Question: What kind of plot is shown here?
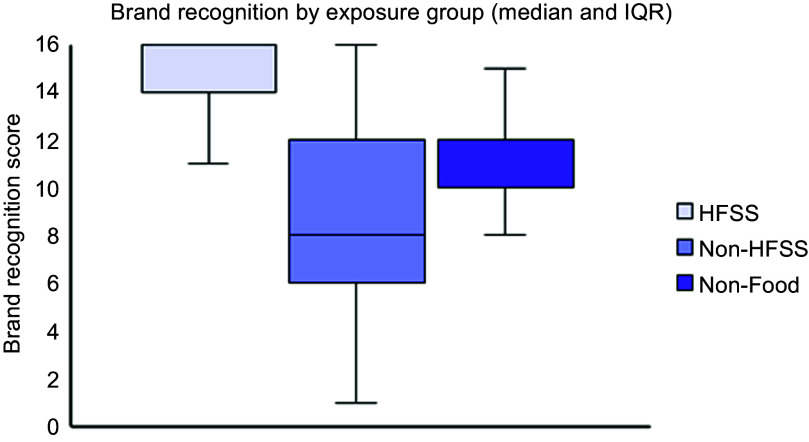
Answer: box